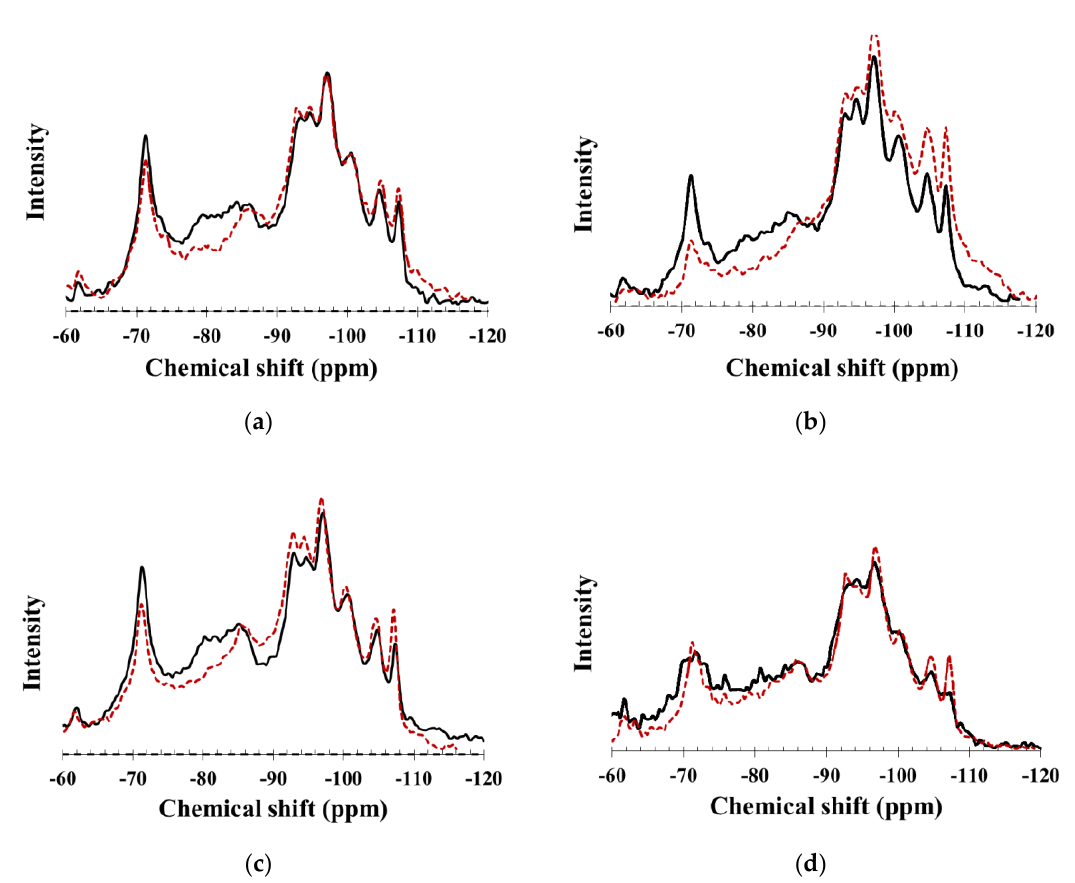
Figure 10. 29 Si MAS NMR results: ( a ) OPC; ( b ) FA15; ( c ) SF35; and ( d ) NS20 (solid black lines are before carbonation and dashed red lines are after carbonation). Table 4. Deconvoluted Intensities of Q n .